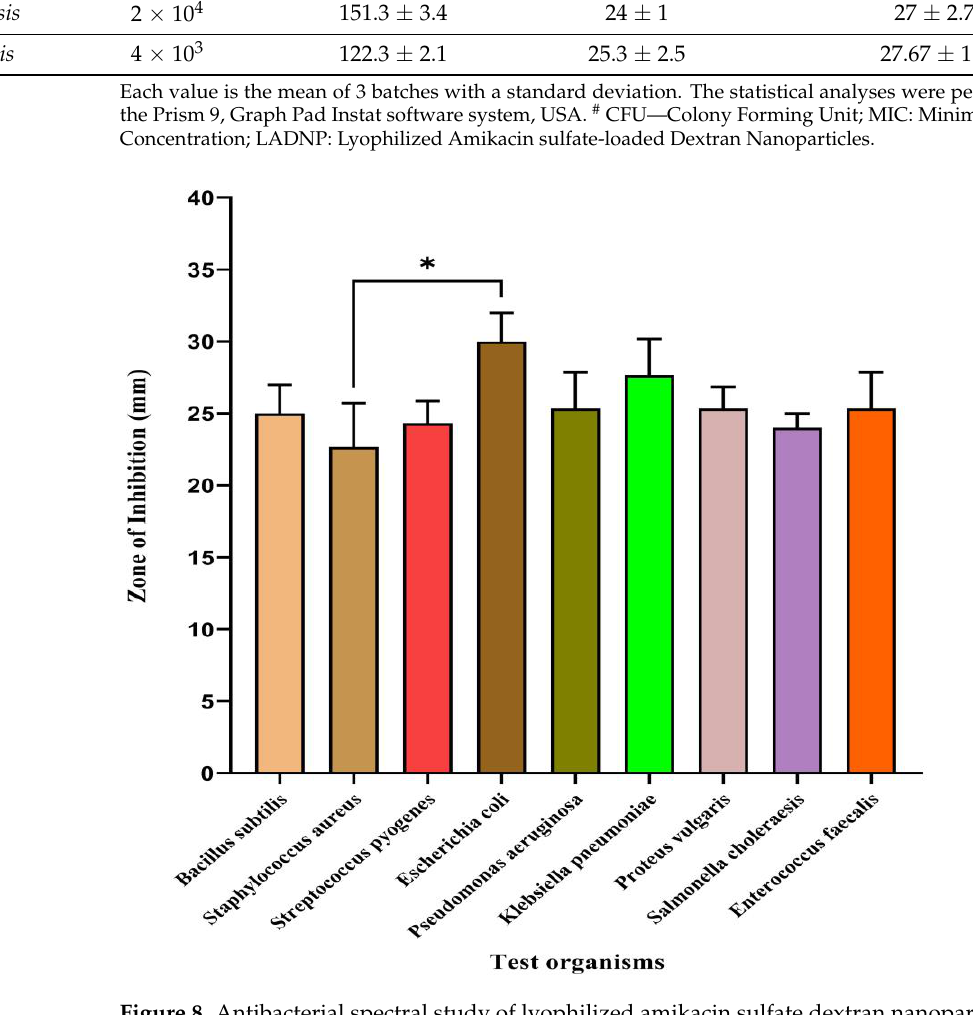
Figure 8. Antibacterial spectral study of lyophilized amikacin sulfate dextran nanoparticles against various human pathogenic bacteria. * Significant at p > 0.05